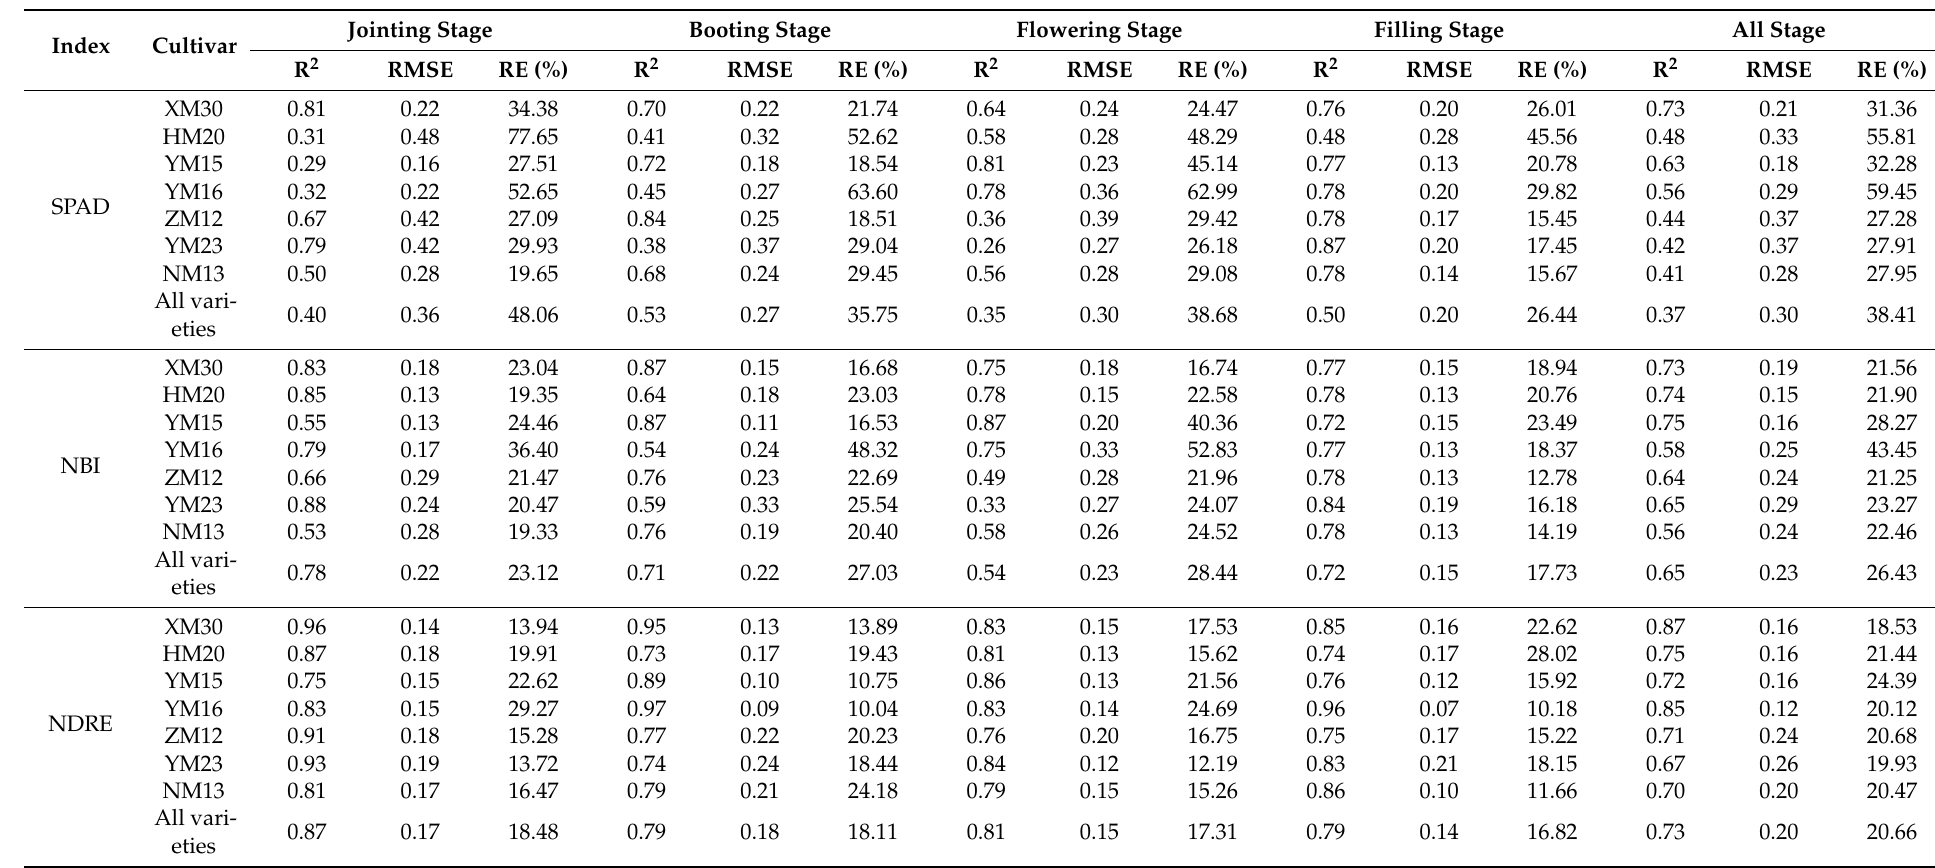
Table 5. Ten-fold cross-validation results for the pair-wise exponential relationship between the SPAD, NBI, NDRE, and NNI across seven cultivars at different growth stages in experiment